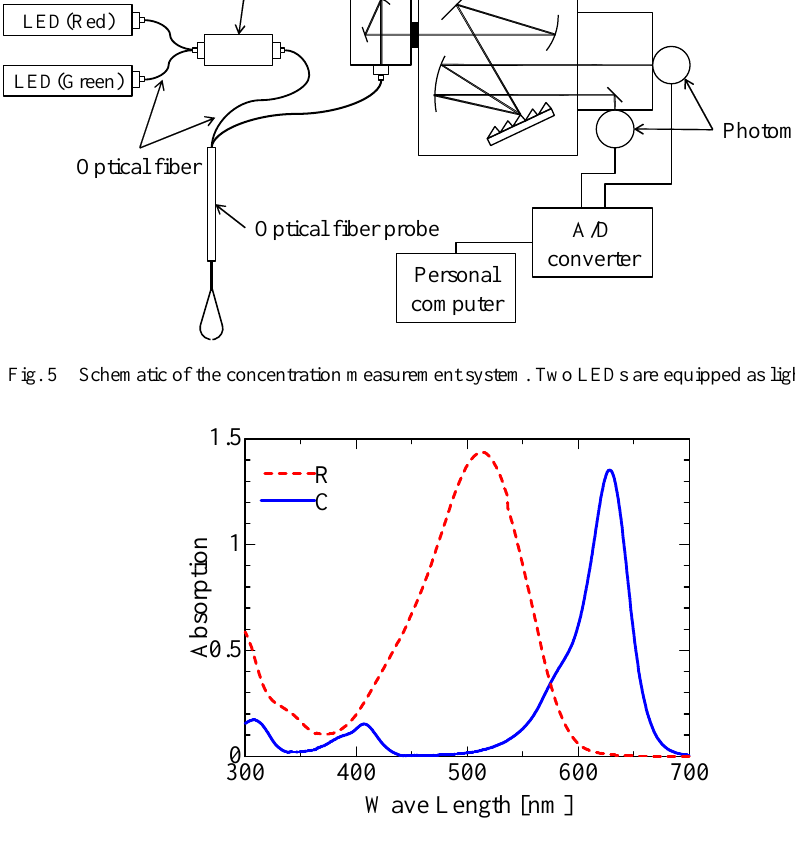
Fig. 6 The light absorption spectra for species R and C. The light absorption spectra for species R and C have a peak value at di ff erent wavelengths, (cid:21) = 515 nm and (cid:21) = 628 nm, respectively. Therefore, the light absorption spectrometric method is suitable for the simultaneous measurements of concentrations of species R and